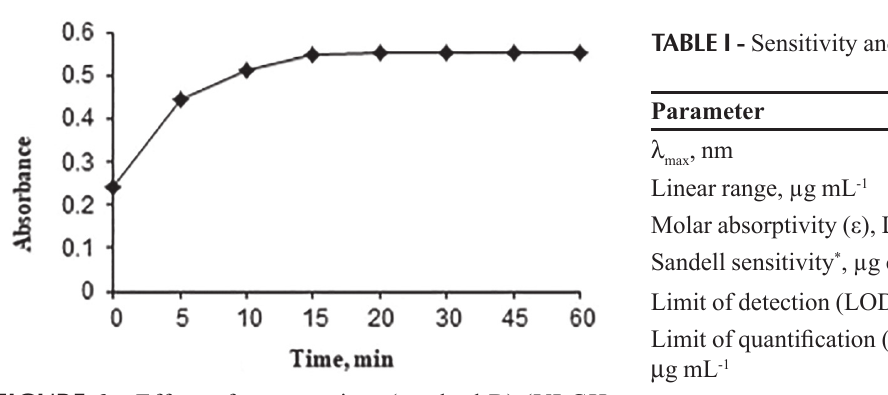
FIGURE 6 - Effect of contact time (method B) (VLGH: 25 µg mL -1 ).